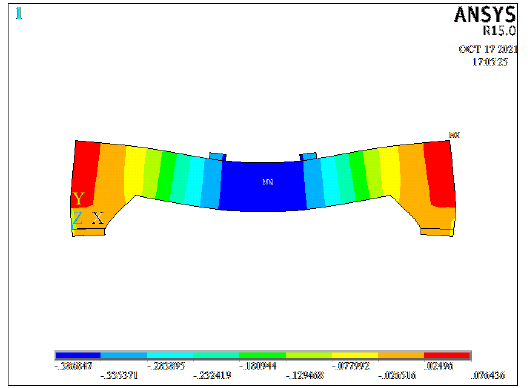
Figure 14. Contour of the deflection of typical RC beam model B2 (hollow).